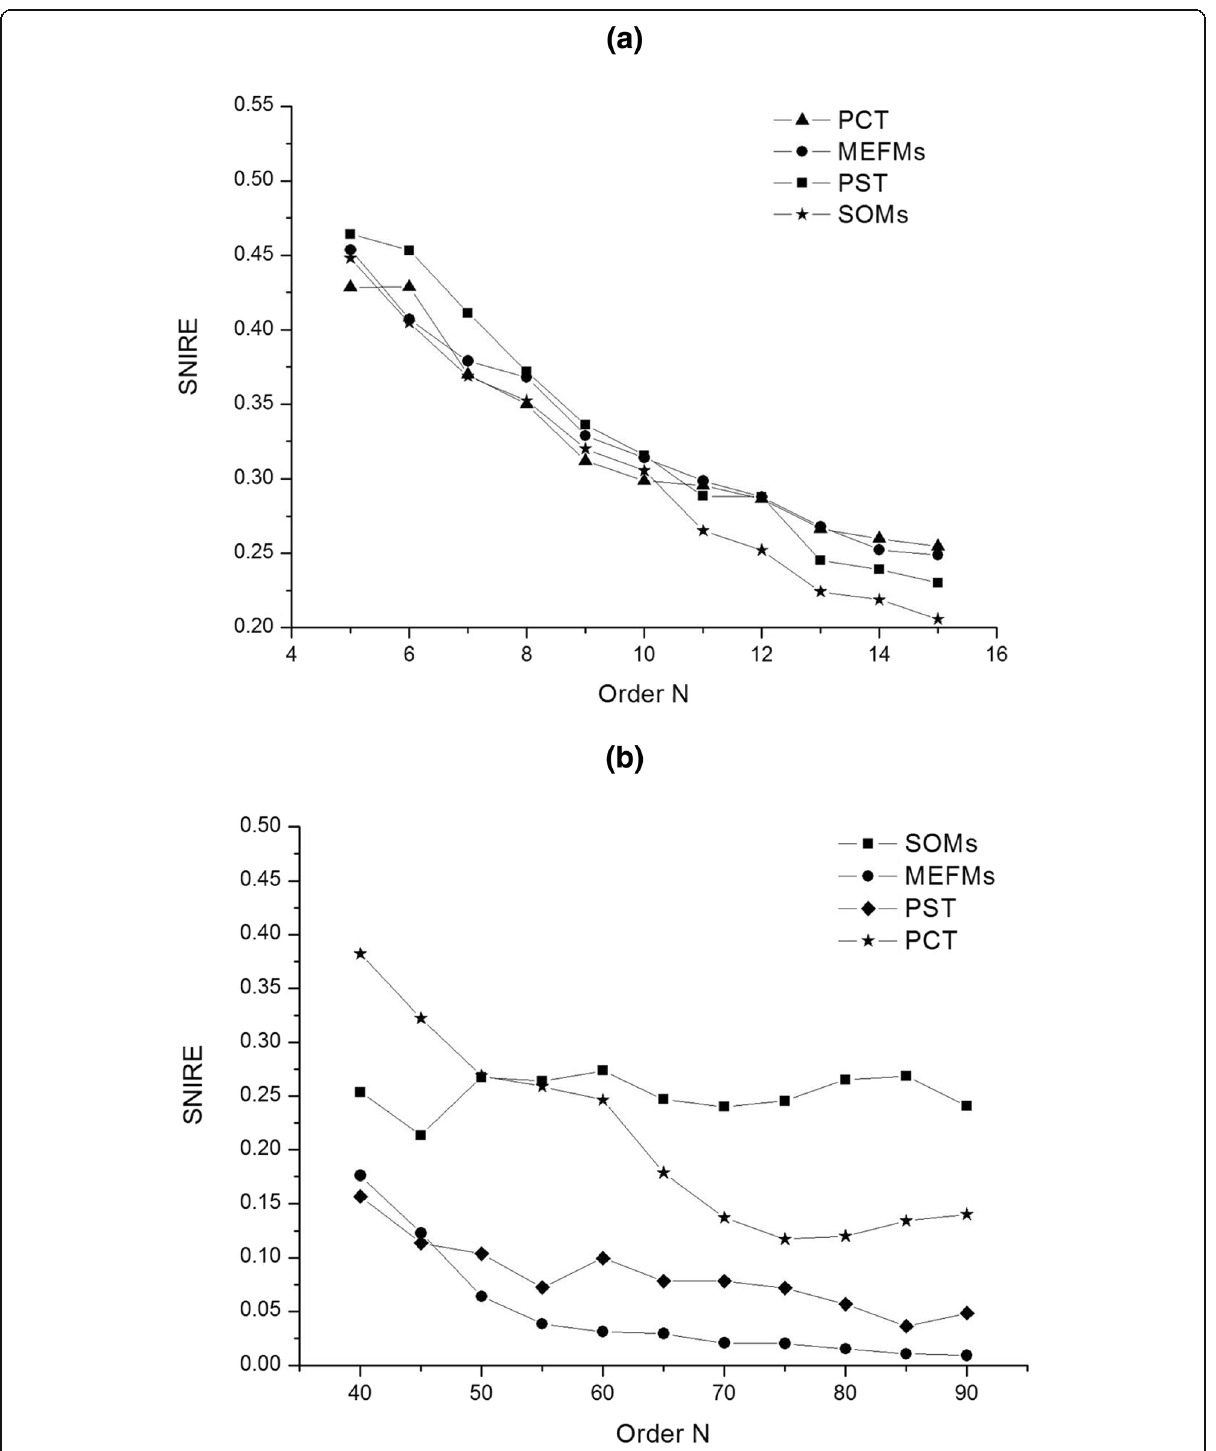
Fig. 12 Comparison of the results of the reconstructed images under MEFMs, SOMs, PCT, and PST. a In lower-orders moments. b In higher-orders